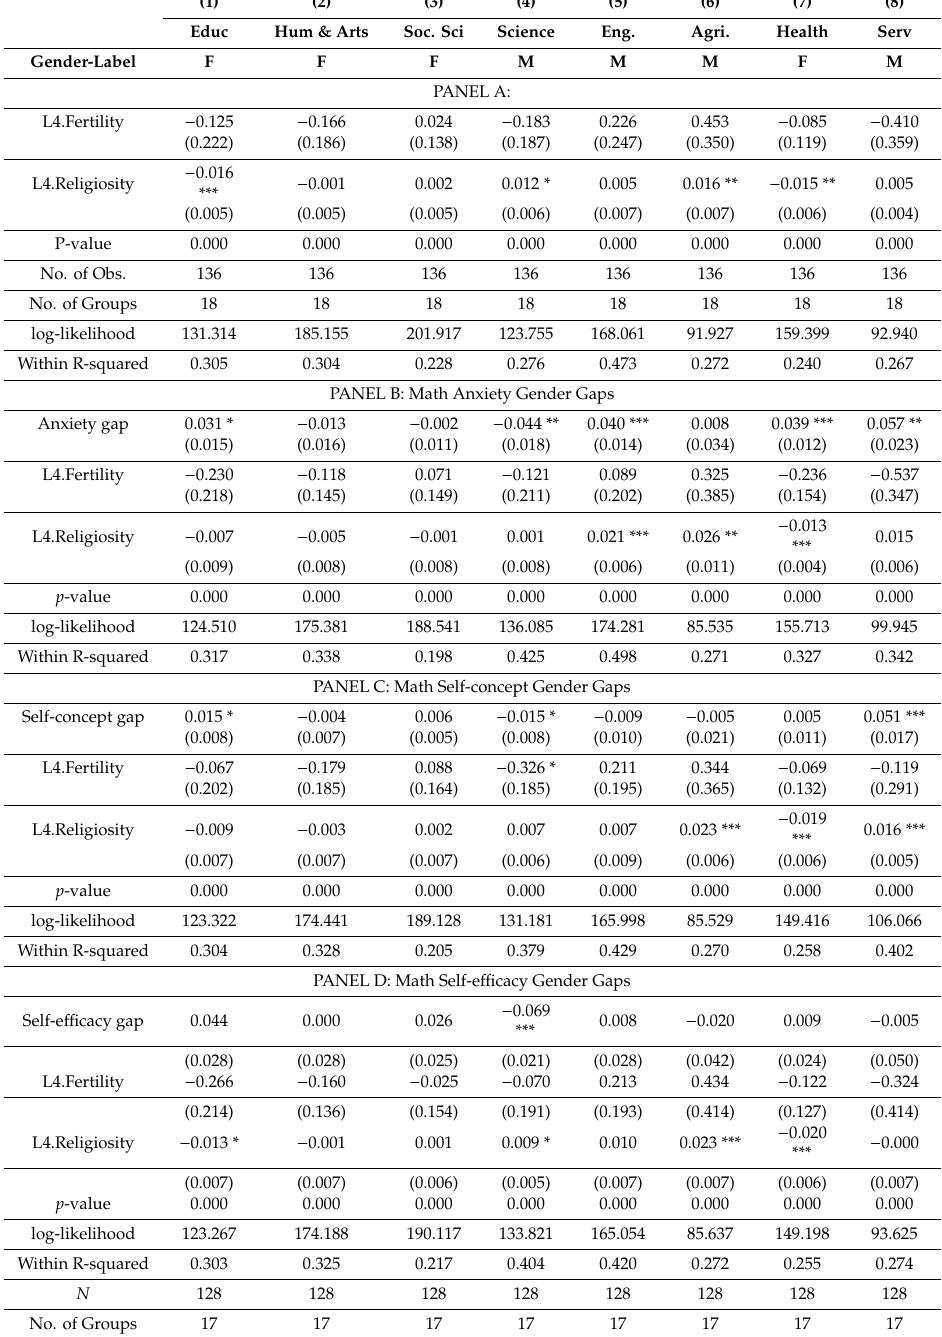
Table 3. Field-level Gender Segregation. Dependent variable: Association Index